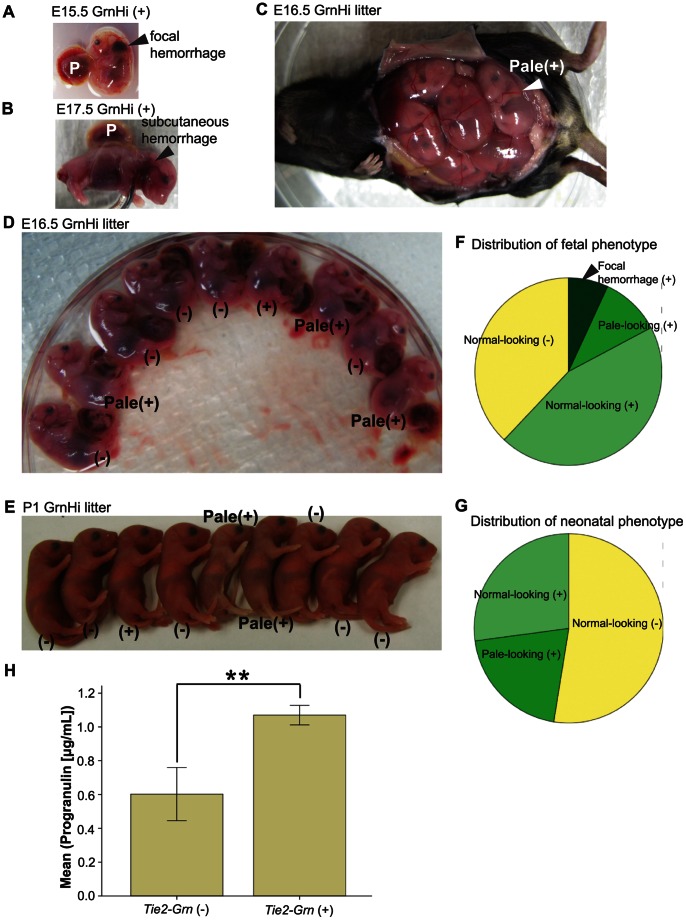

Tie2-Grn dependent abnormalities.(A–D) Appearance of embryos from E15.5 to E16.5 showed subcutaneous hemorrhage, often behind the head, (indicated by arrowheads, P is placenta) (A and B) or pale appearance (C and D) (indicated by arrowhead in C). Litters were genotyped either ex utero (D) or post-natally (E). Externally visible abnormalities were found only in Tie2-Grn positive mice. The phenotype is variable, as some Tie2-Grn positive mice were indistinguishable from the negative littermates. The genotype is indicated in the figure by (+) or (−). (F) The distribution of externally visible abnormalities in E15.5–17.5 fetuses, N = 29 from the GrnHi line and, (G) from P0–P1 live neonates, N = 59 from the GrnHi line. The neonates found dead were not included. (H) Levels of progranulin protein were higher in the amniotic fluid of the Tie2-Grn positive fetuses than negative fetuses (E16.5). Independent samples T-test showed significant difference between the transgenic and negative population, p = 0.007 (two-tailed). Errors bars denote +/− S.E. N = 6 from the GrnHi line only. Asterisks indicate statistical significance in 3H; significance of <0.01 is indicated by **.